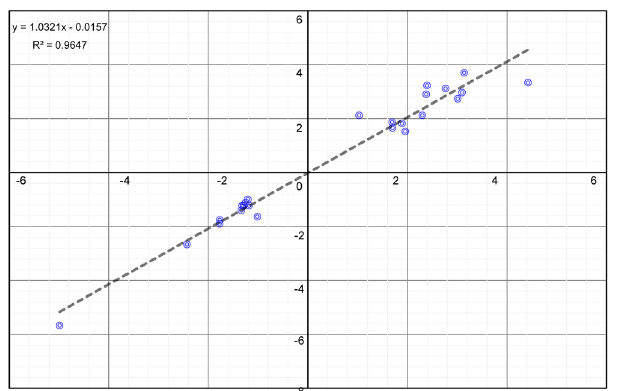
Figure 4. Correlation analysis of differentially expressed genes between QPCR analysis method and transcriptome sequencing